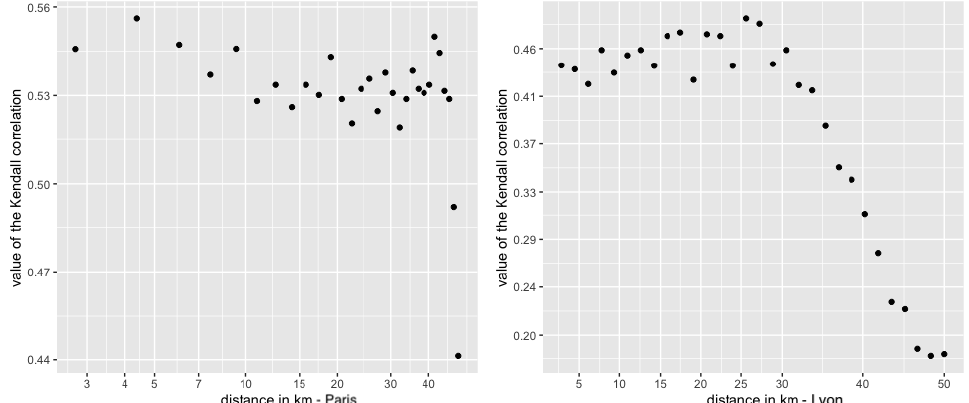
Figure 5. Evolution of the Kendall rank correlation as a function of the distance from which the concentration in air of cadmium is averaged around the moss. On the left, the evolution in the Paris region, and on the right, the evolution in the Lyon region.